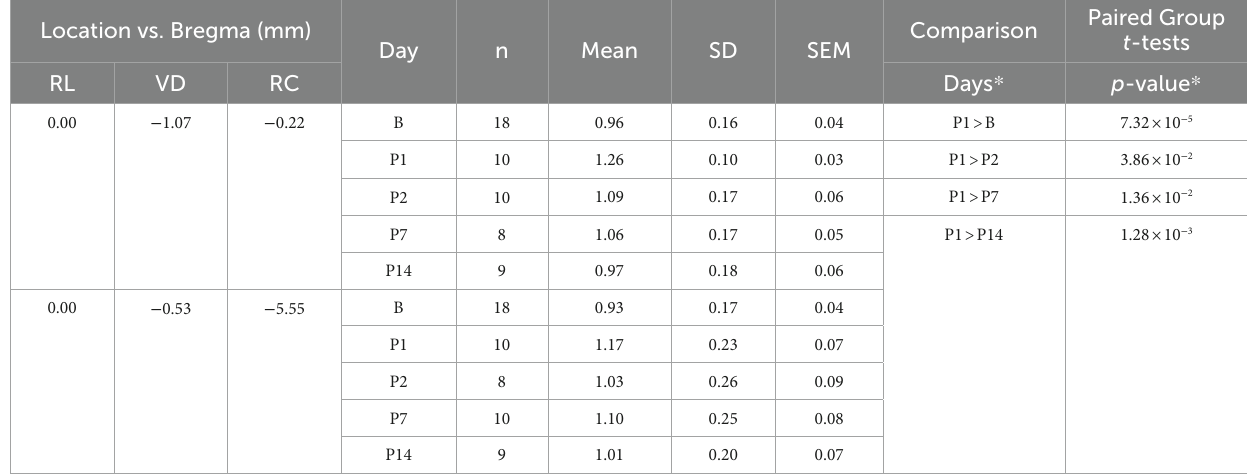
TABLE 6 Diameter of the SSS in T1W GRE + Gd Diff images and statistical comparisons. Location vs. Bregma